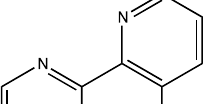
Figure 9. Nitrotriazole derivatives with antitubercular activity [34]. 3. Anti-Inflammatory Activity As mentioned before, nitrated molecules show a wide range of biological activities, not only as a pharmacophore (or toxicophoroe) but as a moiety in a particular compound enhancing its pharmacokinetics and, overall, its pharmacodynamic properties. Fatty acids are not only important in the synthesis of membranes and covering the energetic demands of cells, but they also play a fundamental role as precursors of cellular signaling. Nitro fatty acids are molecules naturally present in humans; they are the product of the reaction between electrophilic fatty acids and nitrogen species. These molecules are closely related